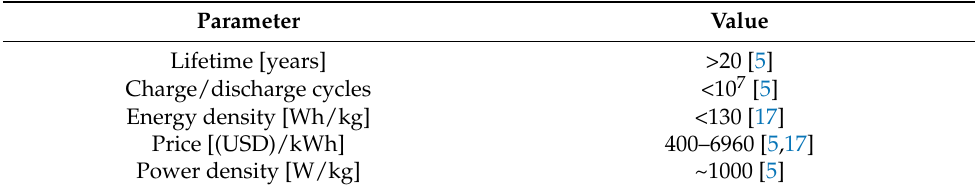
Table 1. General range of FESS performance